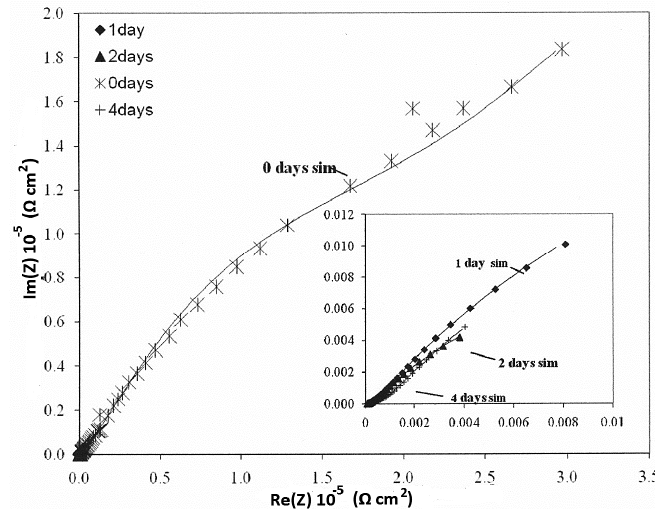
Figure 12. Nyquist plots of impedance spectra, R e (Z), real part of impedance, and I m (Z), imaginary part of impedance, for epoxy coated specimens after 0, 1, 2, or 4 days of exposure in a corrosive environment of 3.5 wt % NaCl